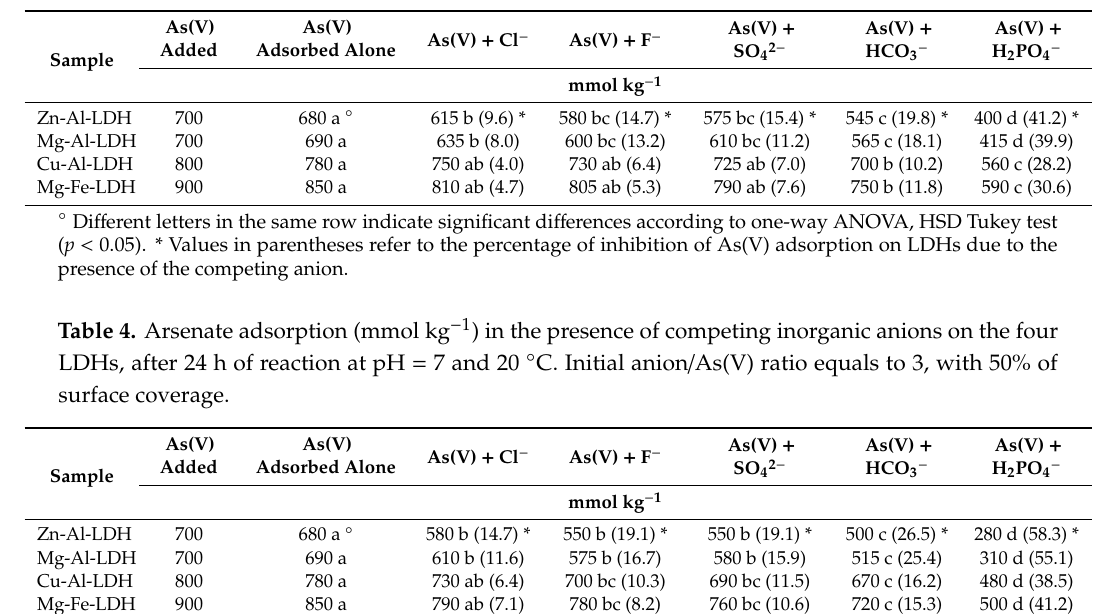
Table 3. Arsenate adsorption (mmol kg − 1 ) in the presence of competing inorganic anions on the four LDHs, after 24 h of reaction at pH = 7 and 20 ◦ C. Initial anion / As(V) ratio equals to 2, with 50% of surface coverage.